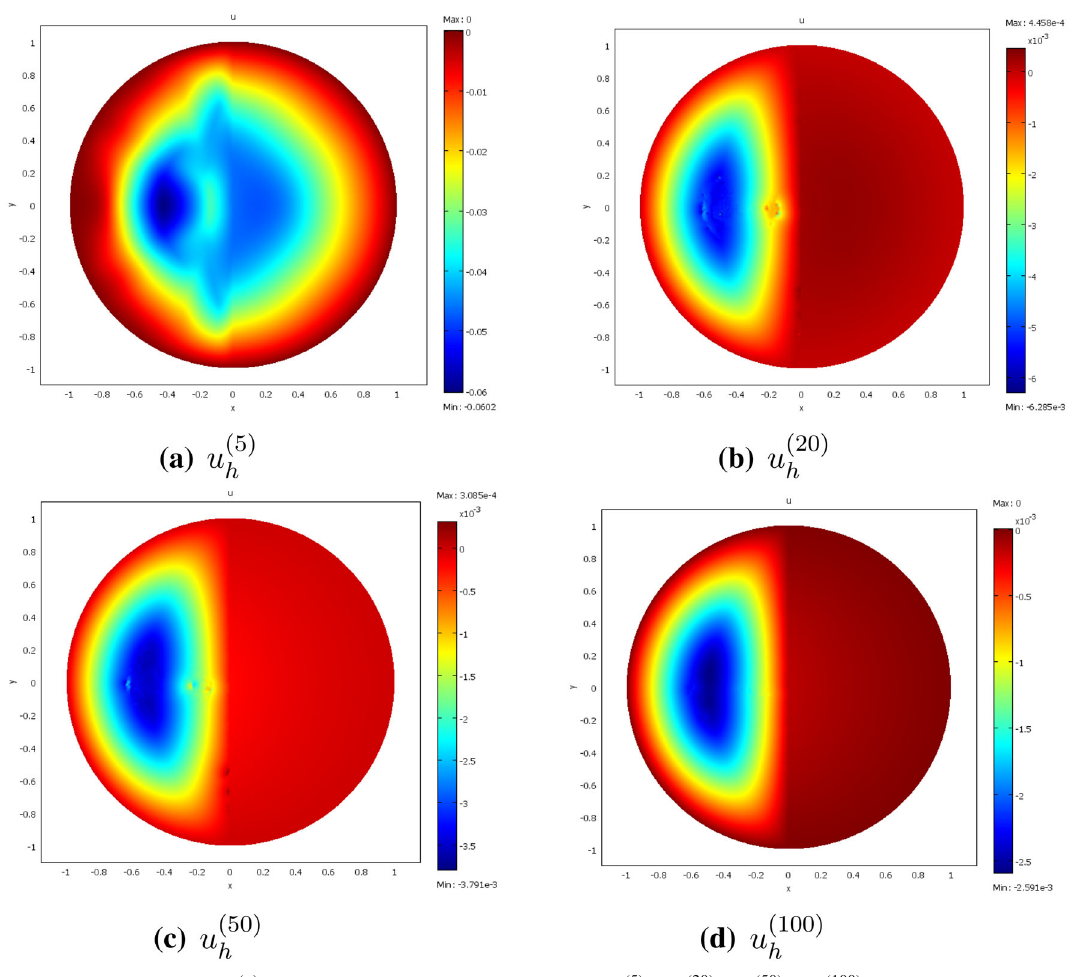
Fig. 3 Numerical solutions u